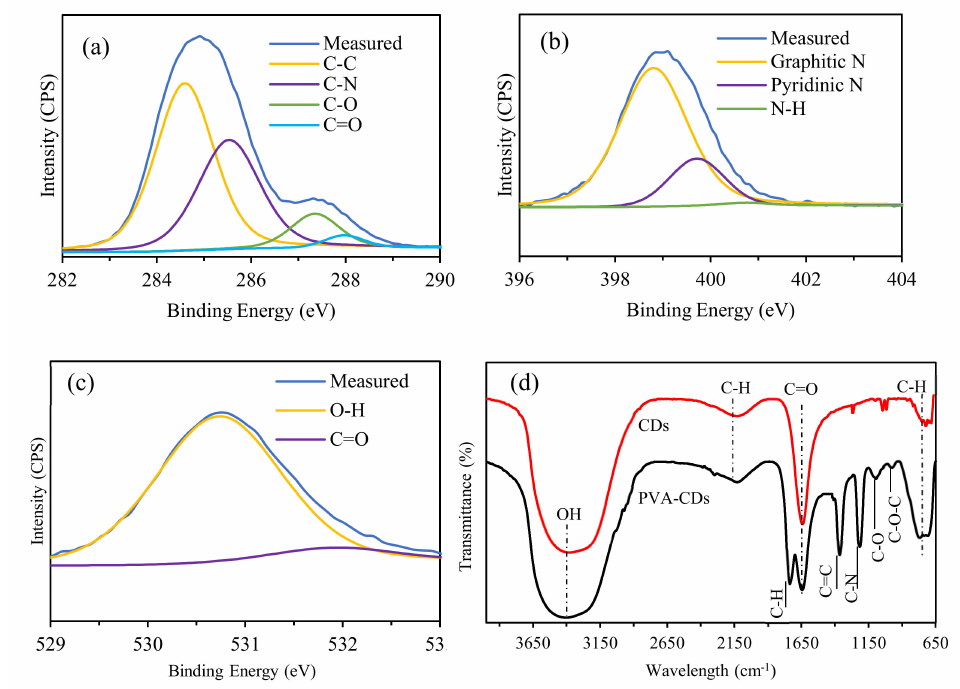
Figure 3. The high-resolution XPS survey of ( a ) C1s, ( b ) N1s and ( c ) O1s, ( d ) FTIR spectra of CDs and